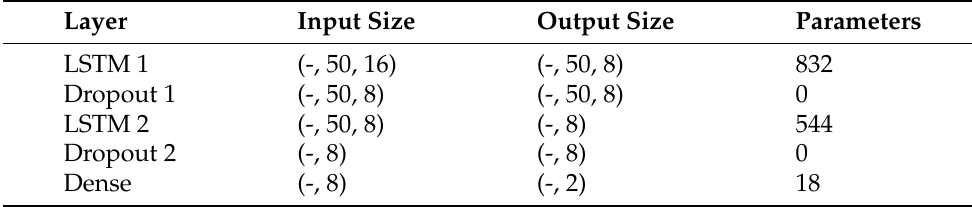
Table 3. Details of RNN